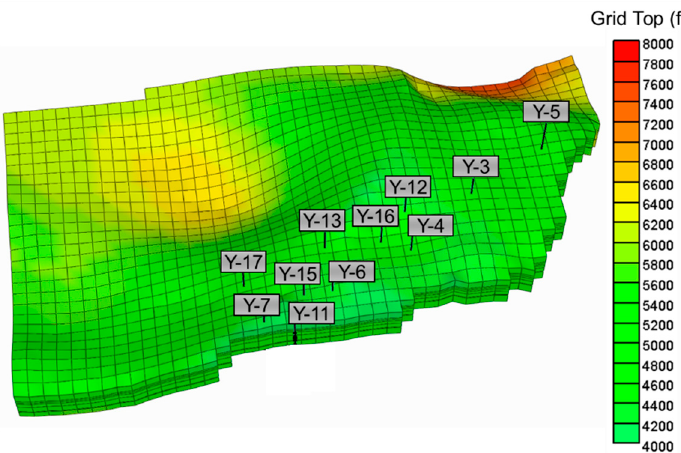
Figure 3. Top view of the three-dimensional model of the YTP sandstone formation.